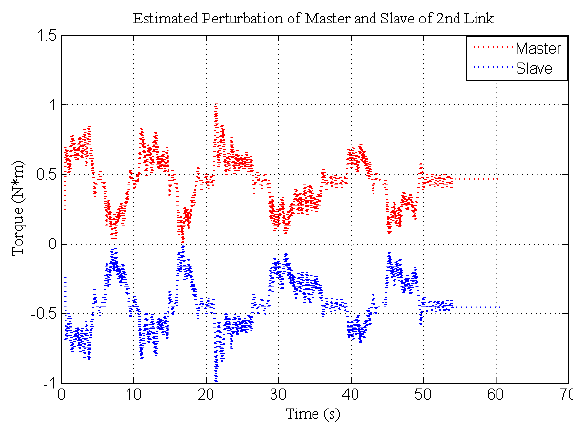
Figure 19. Normalized estimated perturbation of the 2 nd link for the master and the